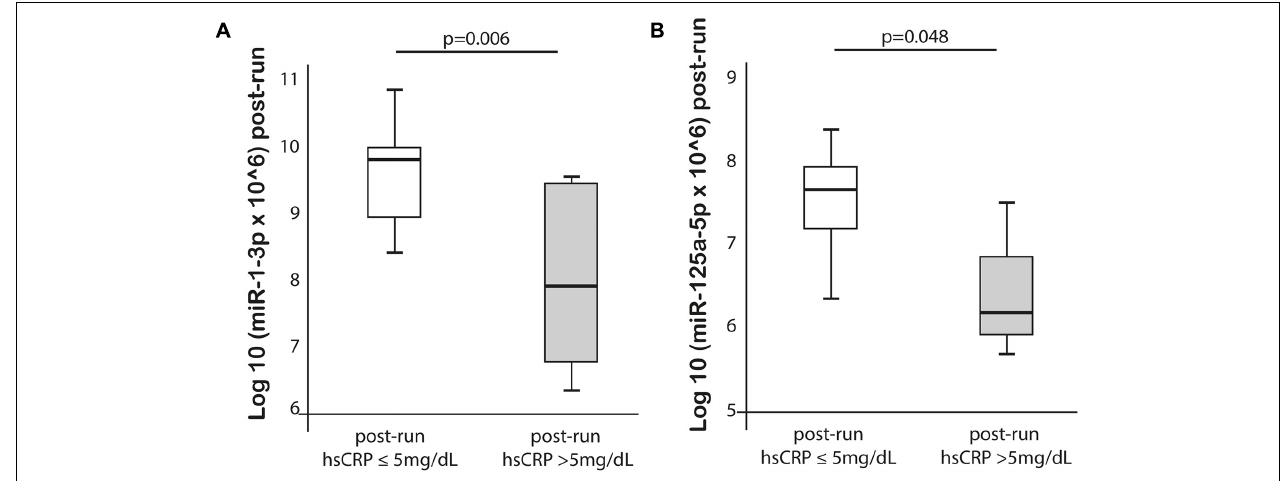
FIGURE 4 | Differences in miR-1-3p and 125a-5p expression after completion the run in subgroups divided based on hs-CRP concentration.